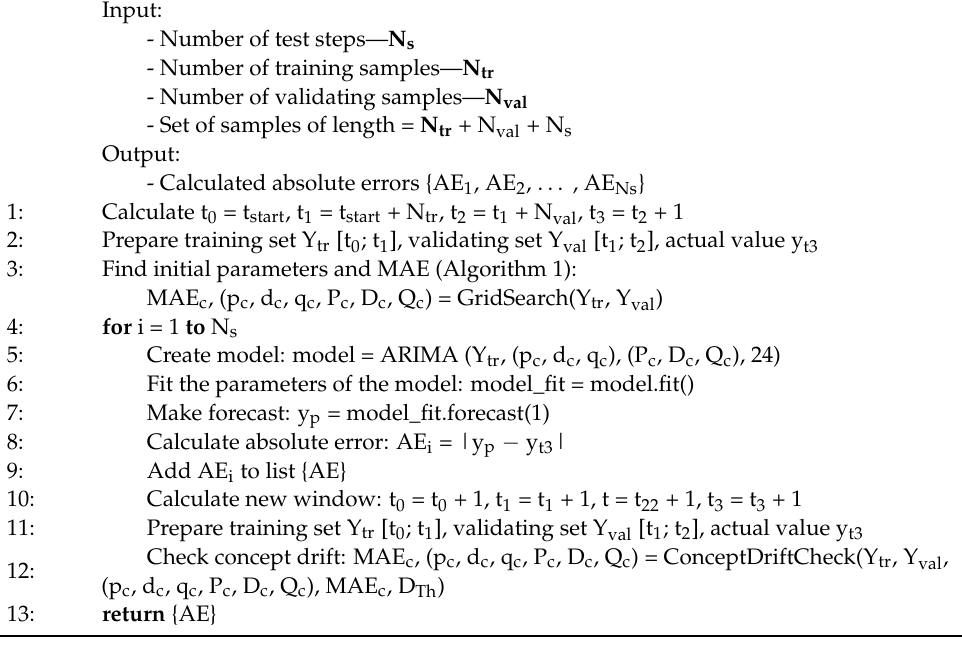
Algorithm 3: Calculate absolute errors using